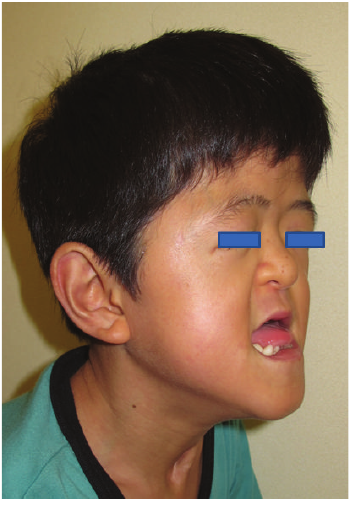
Figure 1: Appearance before